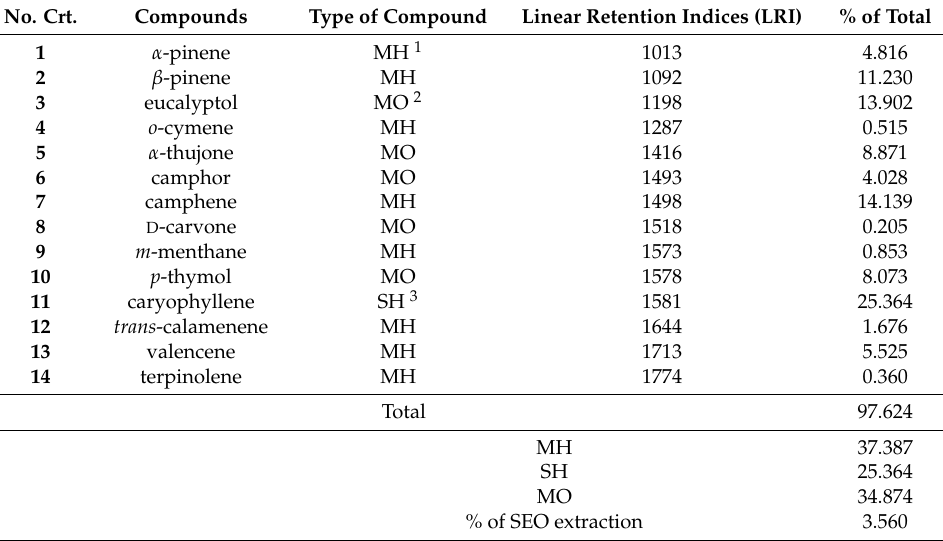
Table 1. Chemical composition of Salvia officinalis essential oils (SEO).